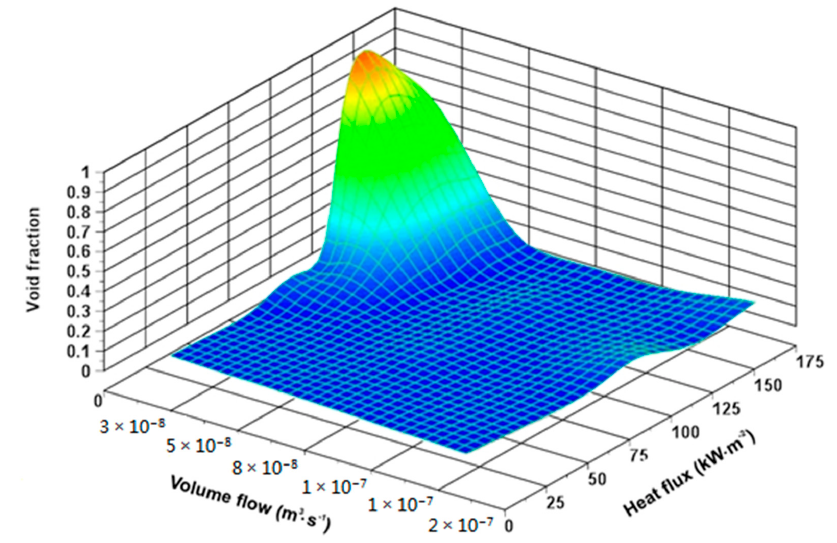
Figure 5. The void fraction versus volumetric flow rate and heat flux.